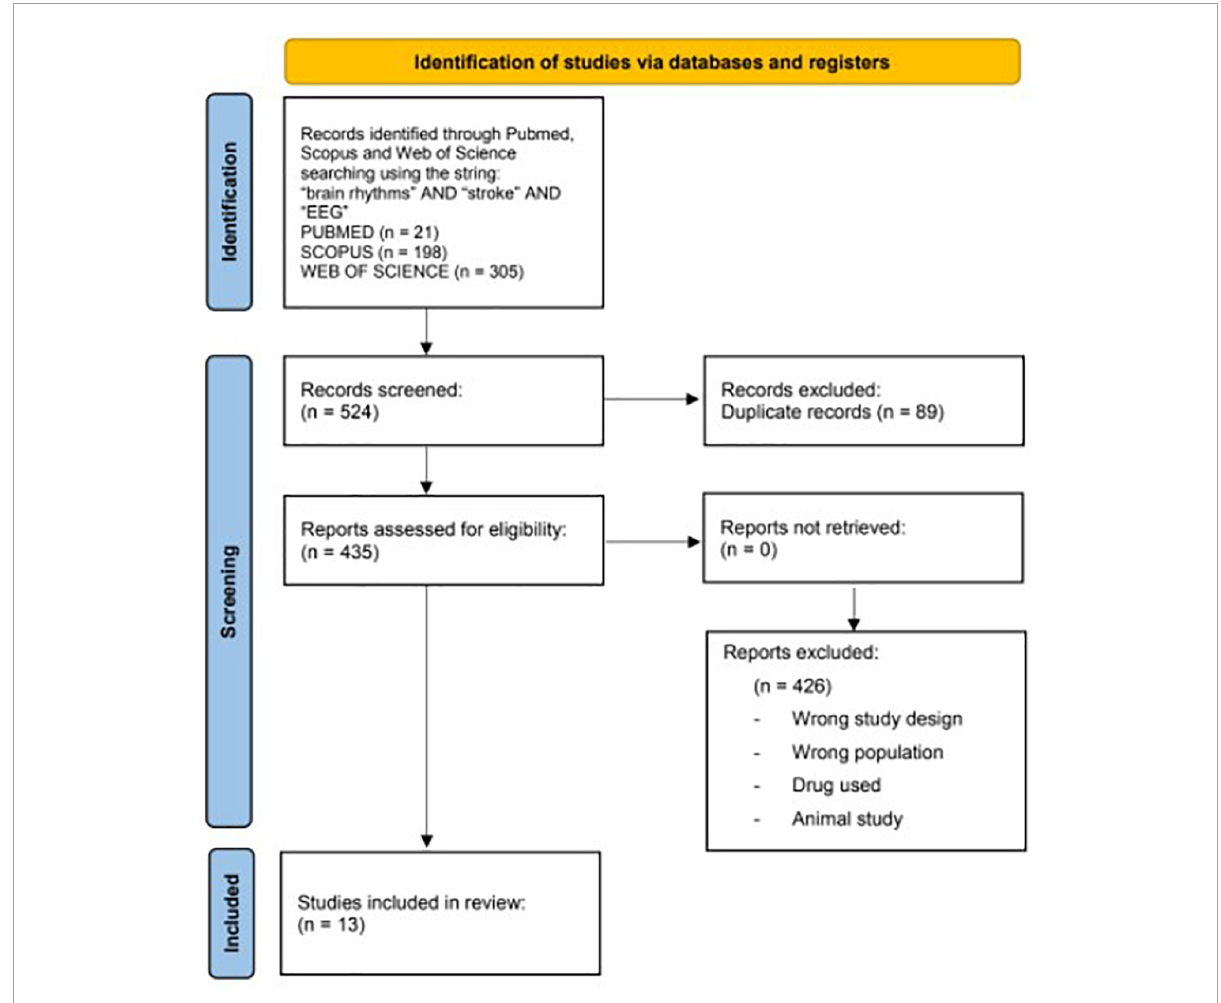
FIGURE1 Preferred reporting items flowchart resuming the paper’s selection